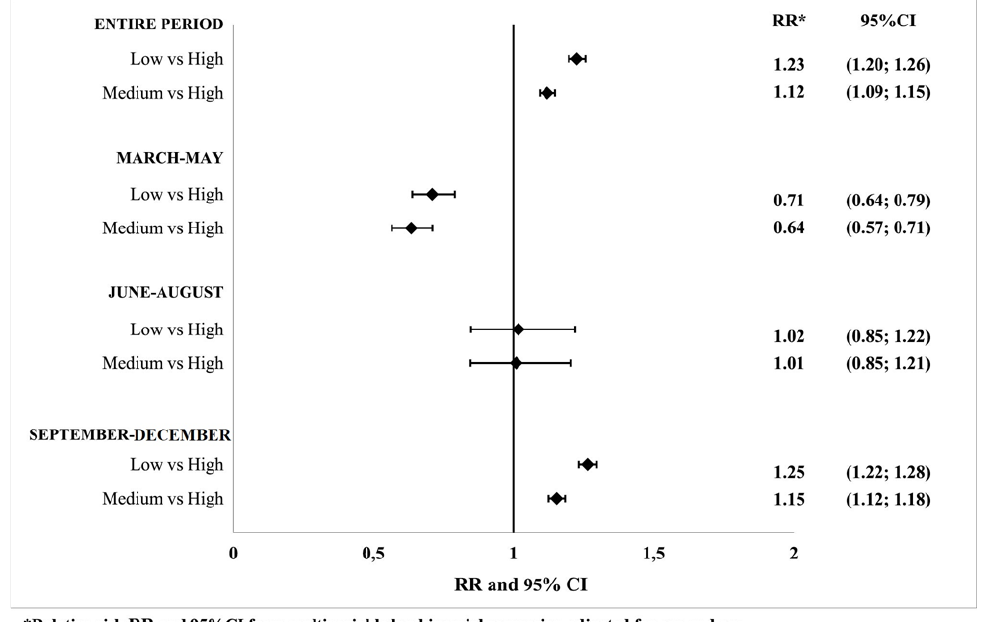
Figure 2. Association between educational level and SARS-CoV-2 infection for the entire period and in the three phases of the pandemic.